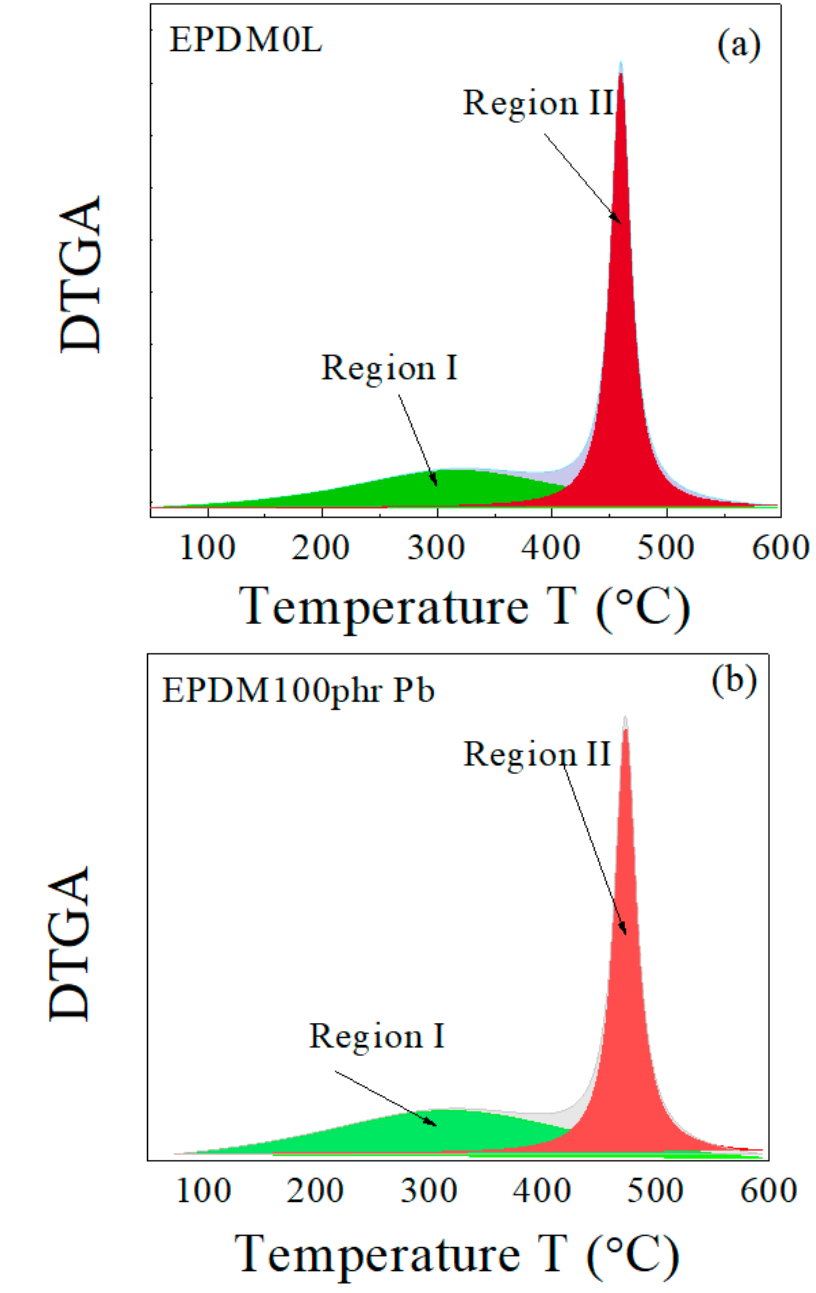
Figure 2. Peak separation of the DTGA curves for EPDM host samples ( a ) without lead and ( b ) with 100 phr lead.